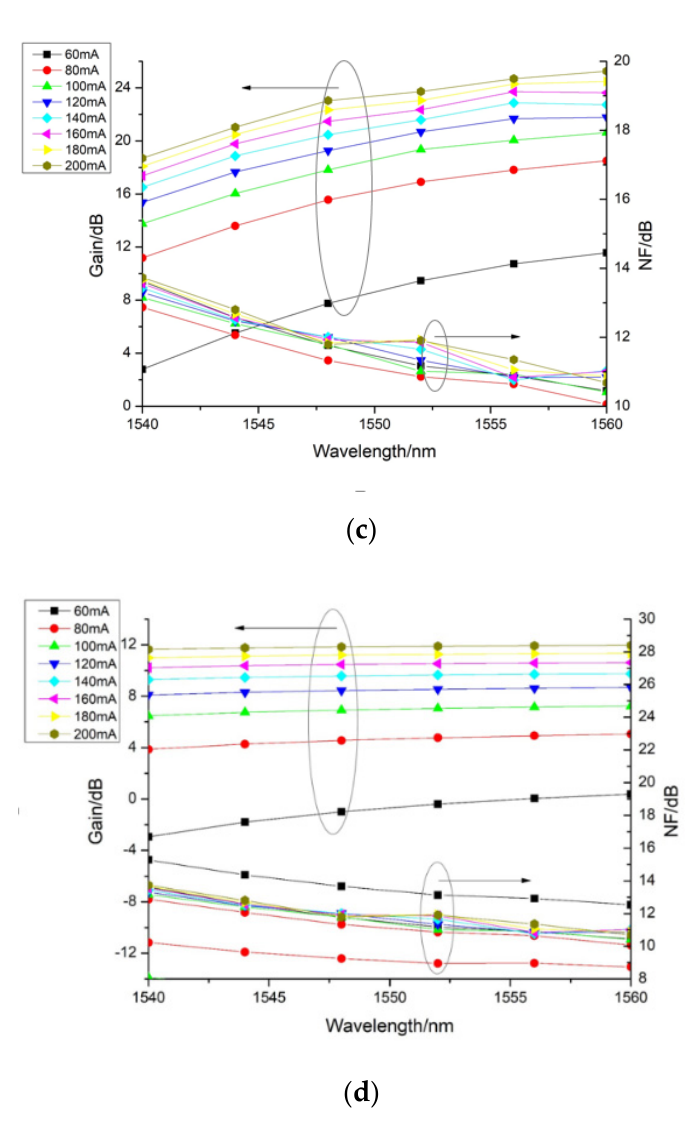
Figure 1. Characteristic analysis diagram of an SOA: ( a ) Gain and NF with input power; ( b ) Gain and NF with bias current; ( c , d ) Gain and NF with wavelength (the left input power is − 25 dBm, the right input power is − 5 dBm).